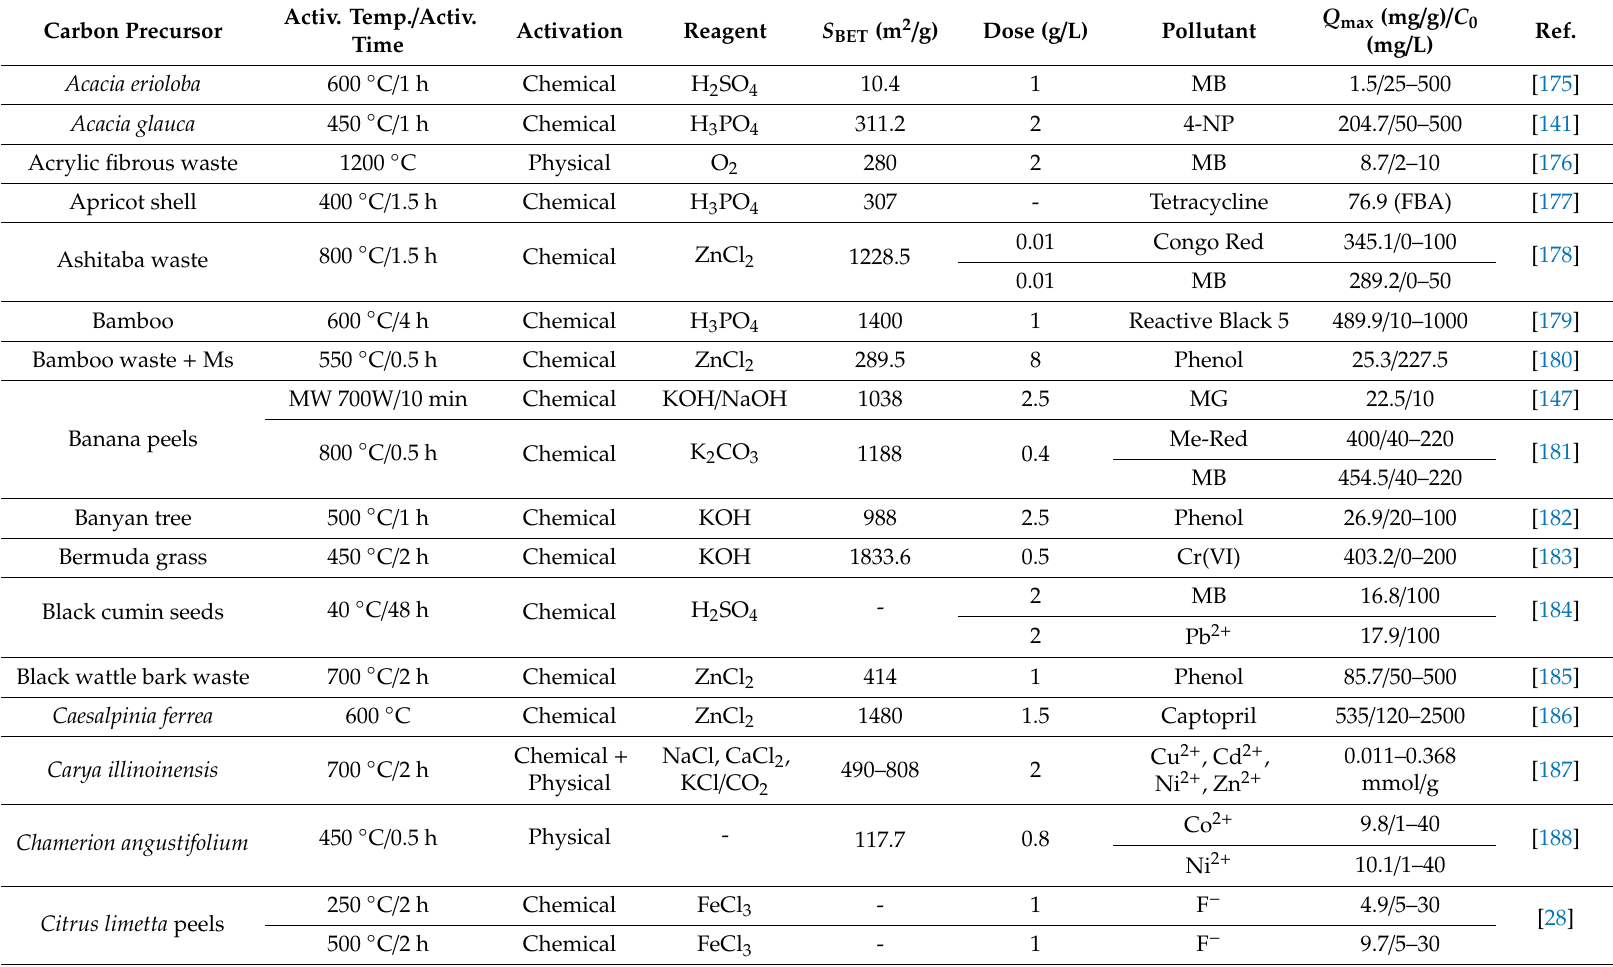
Table 1. The experimental conditions for activated carbons production, specific surface area (S BET ), and adsorption capacities against various toxicants. Carbon